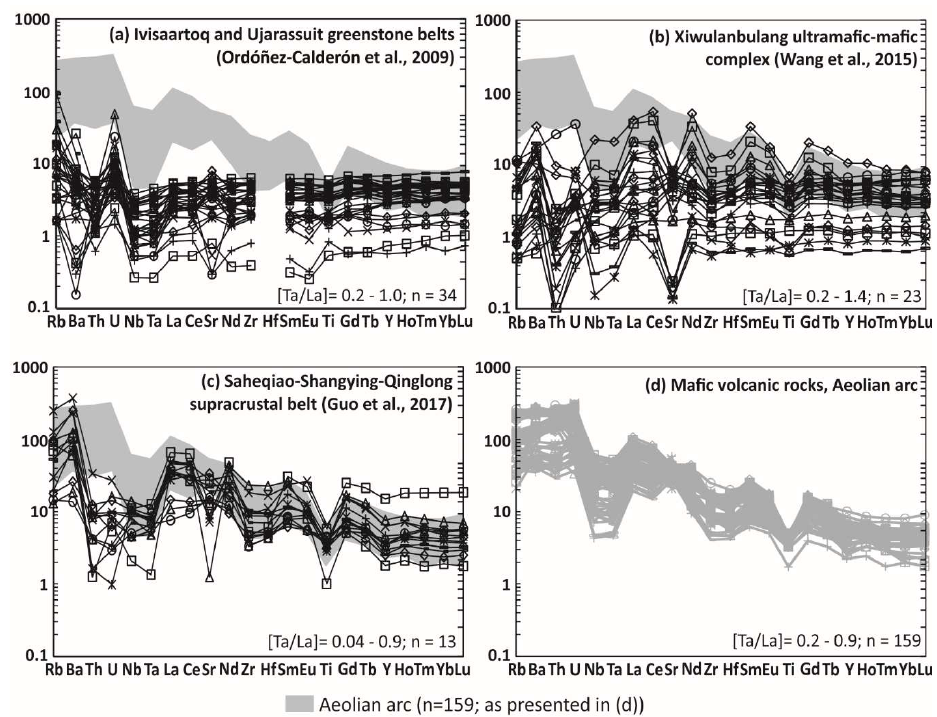
Figure 1. Primitive mantle-normalised trace-element plots comparing Archaean mafic rocks interpreted as the product(s) subduction-related magmatism ( a – c ) to mafic rocks from the Phanerozoic Aeolian arc [14–19], shown in ( d ).